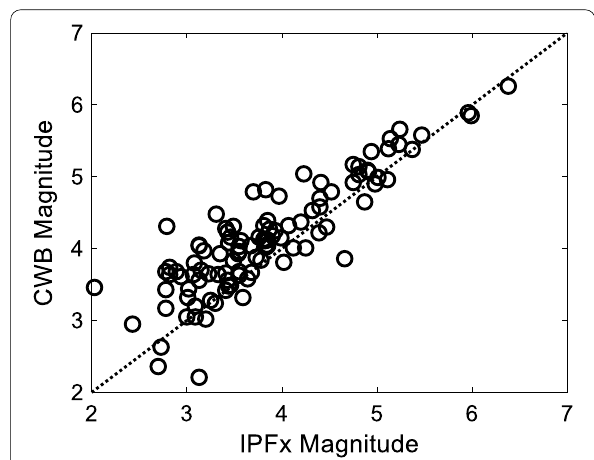
Fig. 11 Magnitude of the CWB manual catalog and IPFx method for the 127 earthquakes with an observed SI